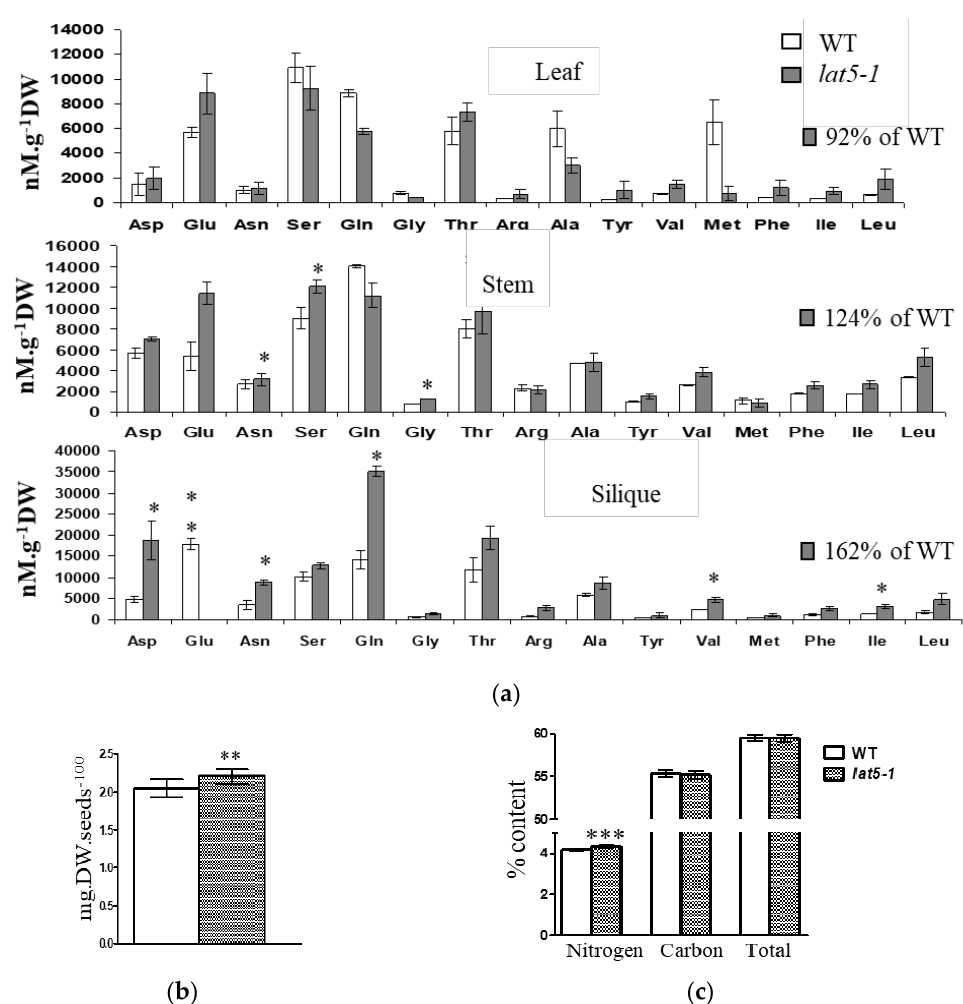
Figure 5. The lat5-1 shows increased free amino acid content in the siliques and increased nitrogen content in the seeds, compared to the WT. ( a ) The total free amino acid concentration is increased in both stem and silique and decreased in the leaves in the lat5-1 compared to the WT. The total free amino acids detected in the WT was arbitrarily taken as 100% to calculate the relative amount in the lat5-1 . Error bar represents the standard deviation of three biological replications. ( b ) The seed weight is significantly increased in the lat5-1 , compared to the WT. ( c ) The percent of nitrogen content is significantly increased in the lat5-1 , compared to the WT. Error bar represents the standard deviation of nine replications from three individual plants with 100 seeds per replication. * p -value < 0.05; ** p -value < 0.01; *** p -value < 0.001.